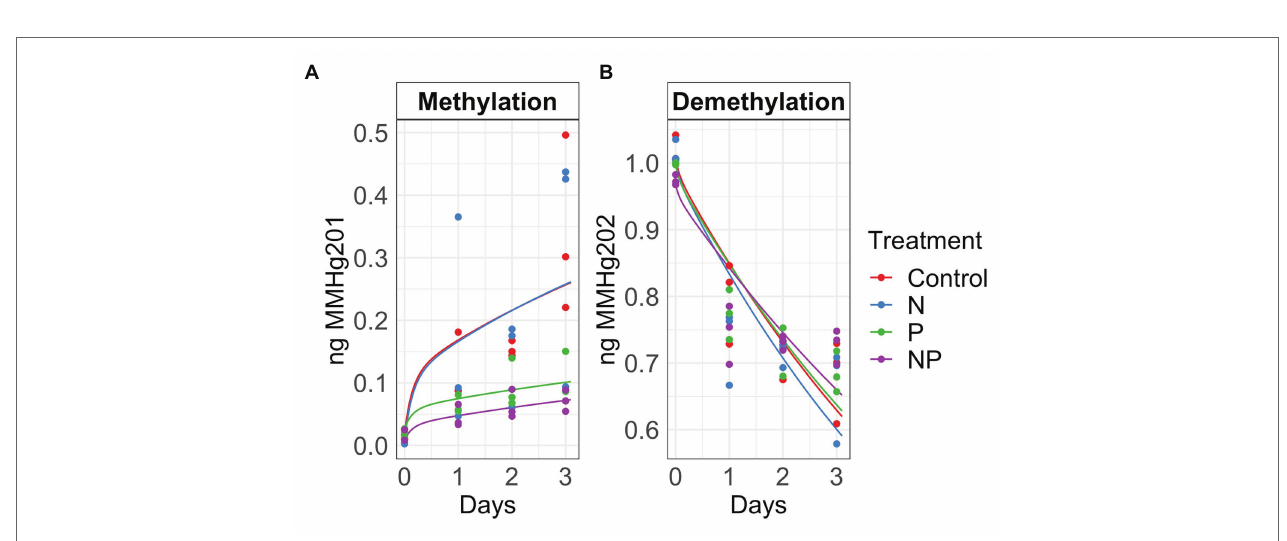
FIGURE 2 | Autumn methylation (A) and demethylation (B) rates calculated with the Transient Availability Kinetic Model of control, nitrate (N), phosphate (P), and nitrate + phosphate (NP) nutrient exposures. The initial 201 HgCl 2 and MM 202 HgCl spikes were 1.8 μ g and 1.05 ng, respectively.